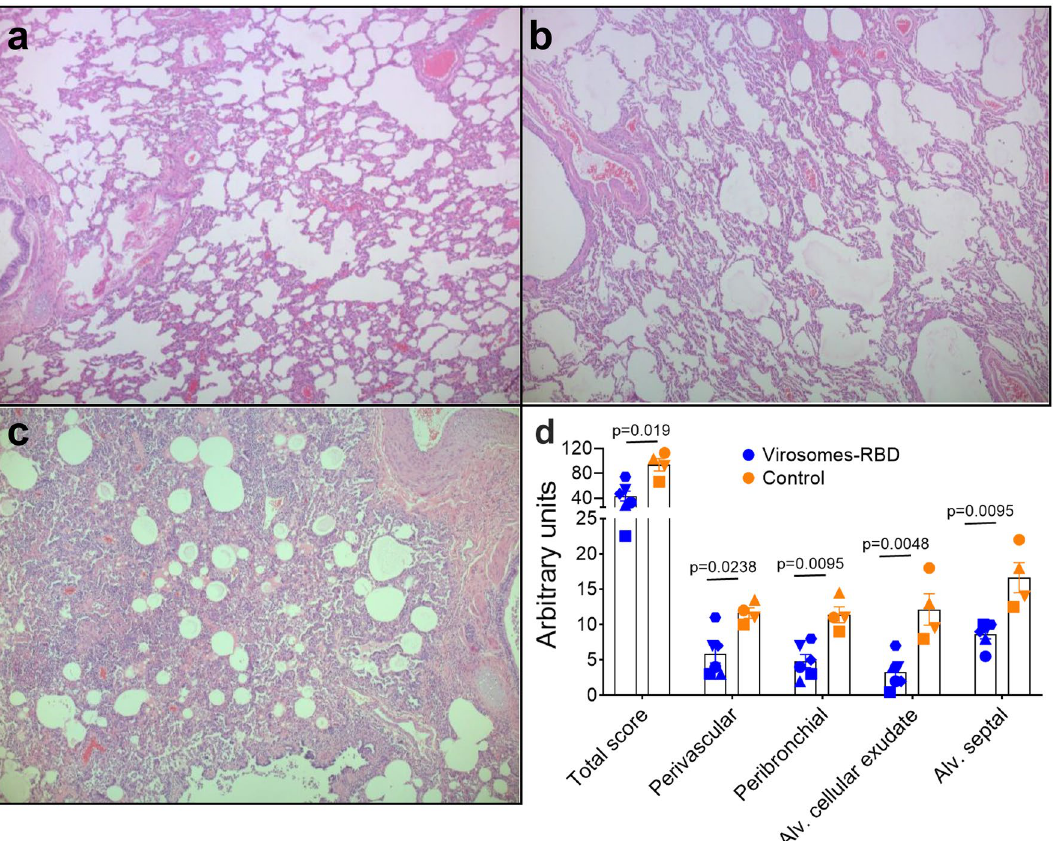
Figure 7. Immunization with virosomes-RBD reduces lung inflammatory pathology. Lung histopathology visualized by light microscopy of hematoxylin and eosin (H&E) tissue staining of lung lobes from representative animals of each group. ( a ) Lung tissue from an uninfected animal showing intact pulmonary structures and lack of inflammation. ( b ) Lung tissue of animal V3 from the virosomes-RBD vaccine group exhibits minimal to mild interstitial infiltrate of inflammatory cells, and rare oedema and fibrin. ( c ) Lung tissue of animal C1 from unvaccinated, infected (control) group with histological features of moderate to severe interstitial inflammation, alveolar cellular infiltrates, abundant oedema and frequent fibrin presence. Image magnification 50x, representative images are shown. ( d ) Lung inflammatory pathology scores for the vaccinated (blue dots) and control group (orange dots). The total pathology score as well as the scores for perivascular inflammatory infiltrates, peribronchiolar inflammatory infiltrates, alveolar cellular exudate, and alveolar septal inflammatory cells are shown for animals immunized with virosomes-RBD (blue symbols) and control animals (orange symbols). Maximum total score is 336 and maximum score per individual parameter is 28. Significant differences between the groups are indicated in the graph by a horizontal line and p-value (Mann–Whitney